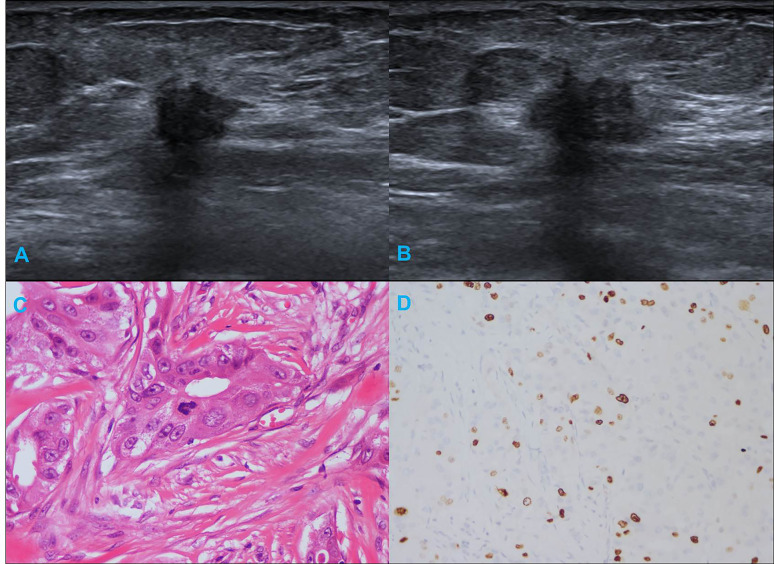
Illustration of TNBC in a 66-year-old female patient. (A, B) Irregular shape, angular margin and posterior acoustic shadow in sonogram (BI-RADS:4C); (C) Histological grade II in HE staining (original magnification × 400); (D) Twenty percent Ki-67 expression in IHC staining (original magnification × 200).